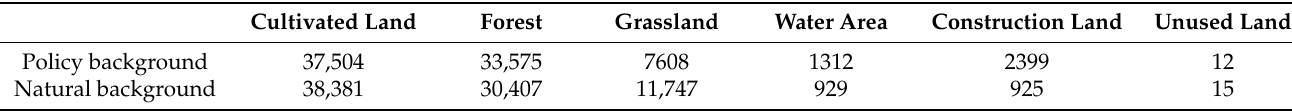
Table 3. Quantitative status of land use types in 2020 under two scenarios (unit: km 2 ). Cultivated Land